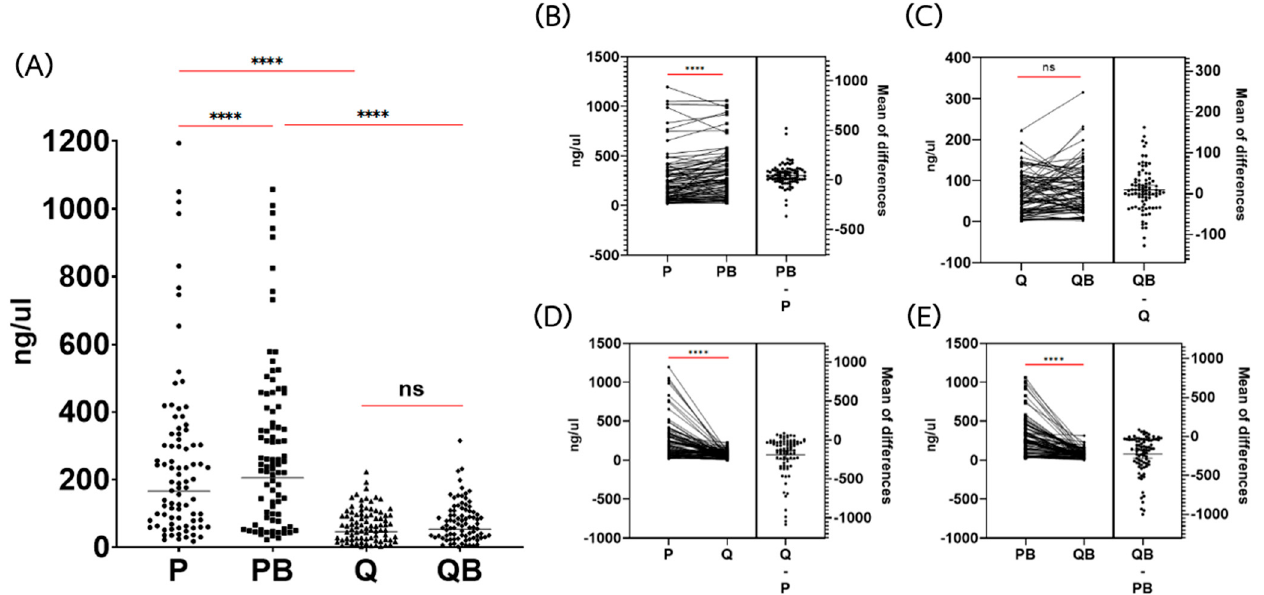
Figure 1. Comparison of the concentration of genomic DNA extracted via the phenol-chloroform extraction method (P), the phenol-chloroform extraction method with glass beads (PB), the QIAamp Fast DNA Stool Mini Kit (Q), and the QIAamp Power Fecal Pro DNA Kit (QB). ( A ) Dot plot of DNA concentration by various extraction methods. Each dot indicates the DNA concentration of each sample. ( B – E ) Estimation plot of DNA concentrations among the extraction methods. Each line in the left panel indicates the comparison of DNA concentration in each sample, extracted by each method. Each dot in the right panel indicates the difference between the DNA concentrations of each sample. The bar indicates the mean of the difference between concentrations. **** Statistical differences using Wilcoxon matched-pairs signed-rank tests ( p < 0.0001), ns: non-significantly dif- ferent ( p > 0.05).